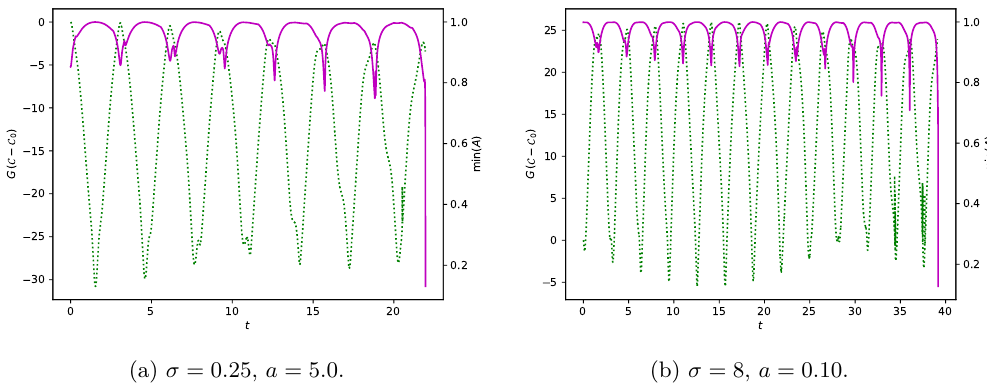
Figure 4. Volume complexity and minimum A ( x ) vs t for two sets of initial data. Both are massless scalars in AdS 4 . Complexity is dotted green and minimum A is solid magenta. The scales are shown on the left and right vertical axes